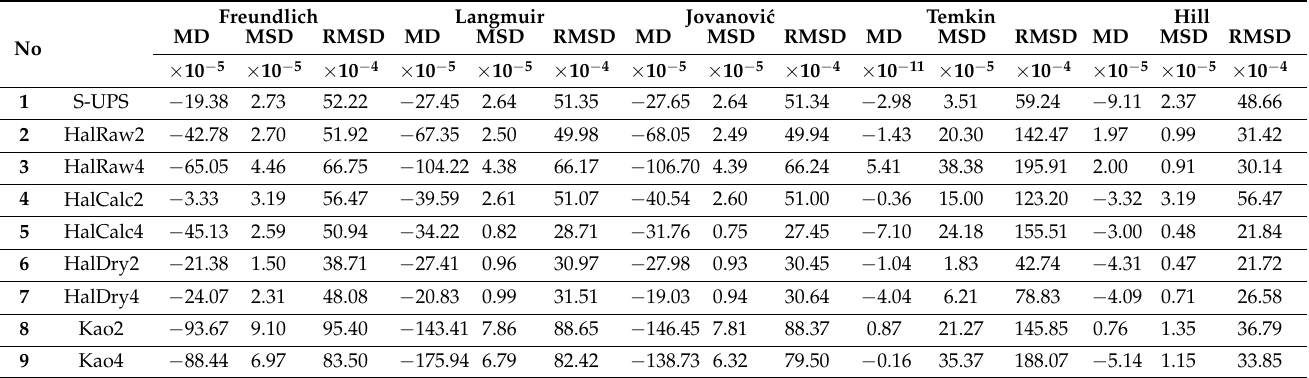
Table 5. The values of mean deviation (MD), mean square deviation variance (MSD) and root-mean square deviation (RMSD) for measurement data modeled with the Freundlich, Langmuir, Jovanovi´c, Temkin and Hill